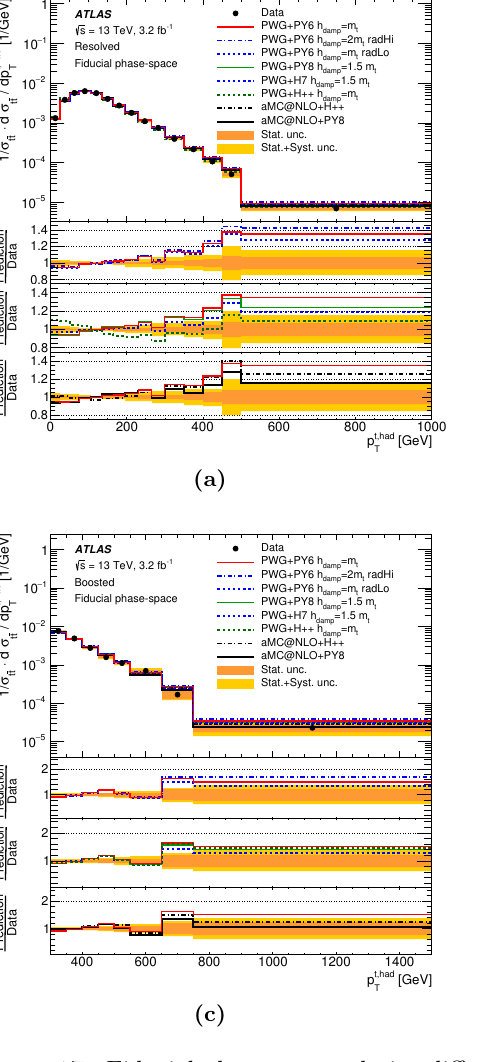
Figure 17. Fiducial phase-space relative di(cid:11)erential cross-sections as a function of the (a) trans- (cid:12) (cid:12) verse momentum ( p t; had ) and (b) the absolute value of the rapidity ( (cid:12) y t; had (cid:12) ) of the hadronic top T quark in the resolved topology, and corresponding results in the boosted topology (c), (d). The yellow bands indicate the total uncertainty of the data in each bin. The Powheg + Pythia6 generator with h damp = m t and the CT10 PDF is used as the nominal prediction to correct for detector e(cid:11)ects. The lower three panels show the ratio of the predictions to the data. The (cid:12)rst panel compares the three Powheg + Pythia6 samples with di(cid:11)erent settings for additional radiation, the second panel compares the nominal Powheg + Pythia6 sample with the other Powheg samples and the third panel compares the nominal Powheg + Pythia6 sample with the MadGraph5 a MC@NLO